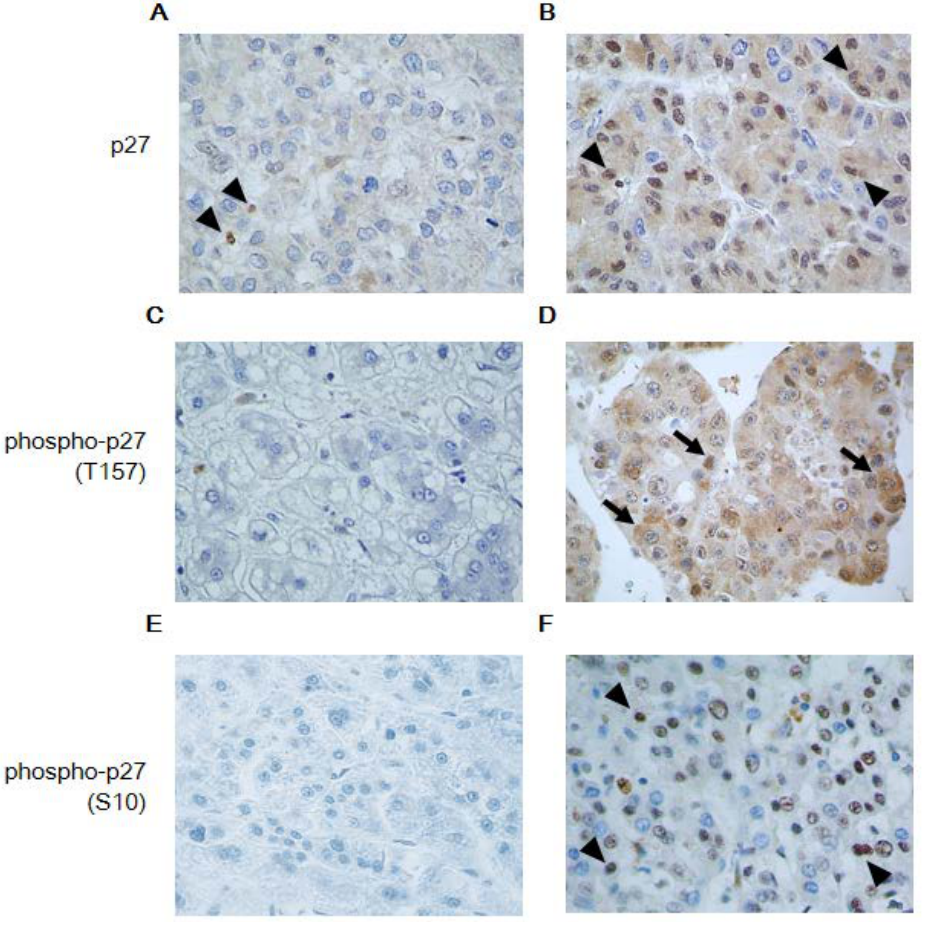
Figure 1. Representative immunohistochemical staining of p27, phospho-27 (T157), and phospho-p27 (S10) in NASH-related HCC tissues. Negative and positive immunostaining for p27 ( A and B ), phospho-p27 (T157) ( C and D ), and phospho-p27 (S10) ( E and F ) in NASH-related HCC tissue samples. Positive immunostaining for p27 and phospho-p27 (S10) were localized in the nuclei (arrowhead), while phospho-p27 (T157) was expressed in either nuclei or cytoplasm (arrow) (original magnification: